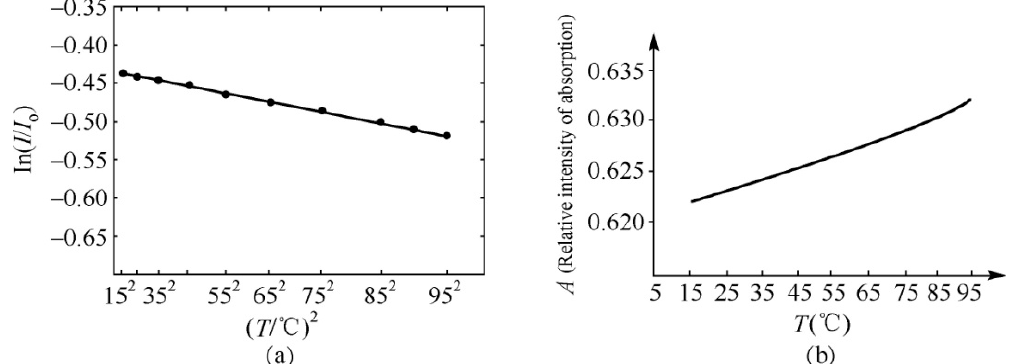
Figure 10. Temperature dependences of intensity of peaks in the infrared spectrum of collagen: ( a ) Relation of logarithm of relative intensity, Ln ( I / I 0 ), versus (T/°C) 2 for a 1650-cm − 1 peak, where “ ● ” denotes experimental data; and ( b ) linear temperature dependence of relative intensity, I / I 0 , for a 1666-cm − 1 peak.